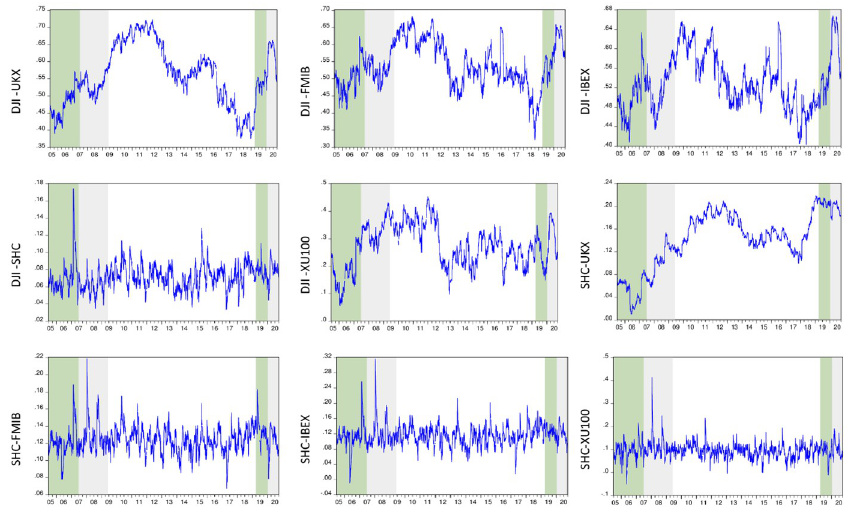
Fig 2. Dynamic conditional correlations of stock markets (DCC-GARCH results). Green and gray areas demonstrate the pre-crisis and crisis periods, respectively.